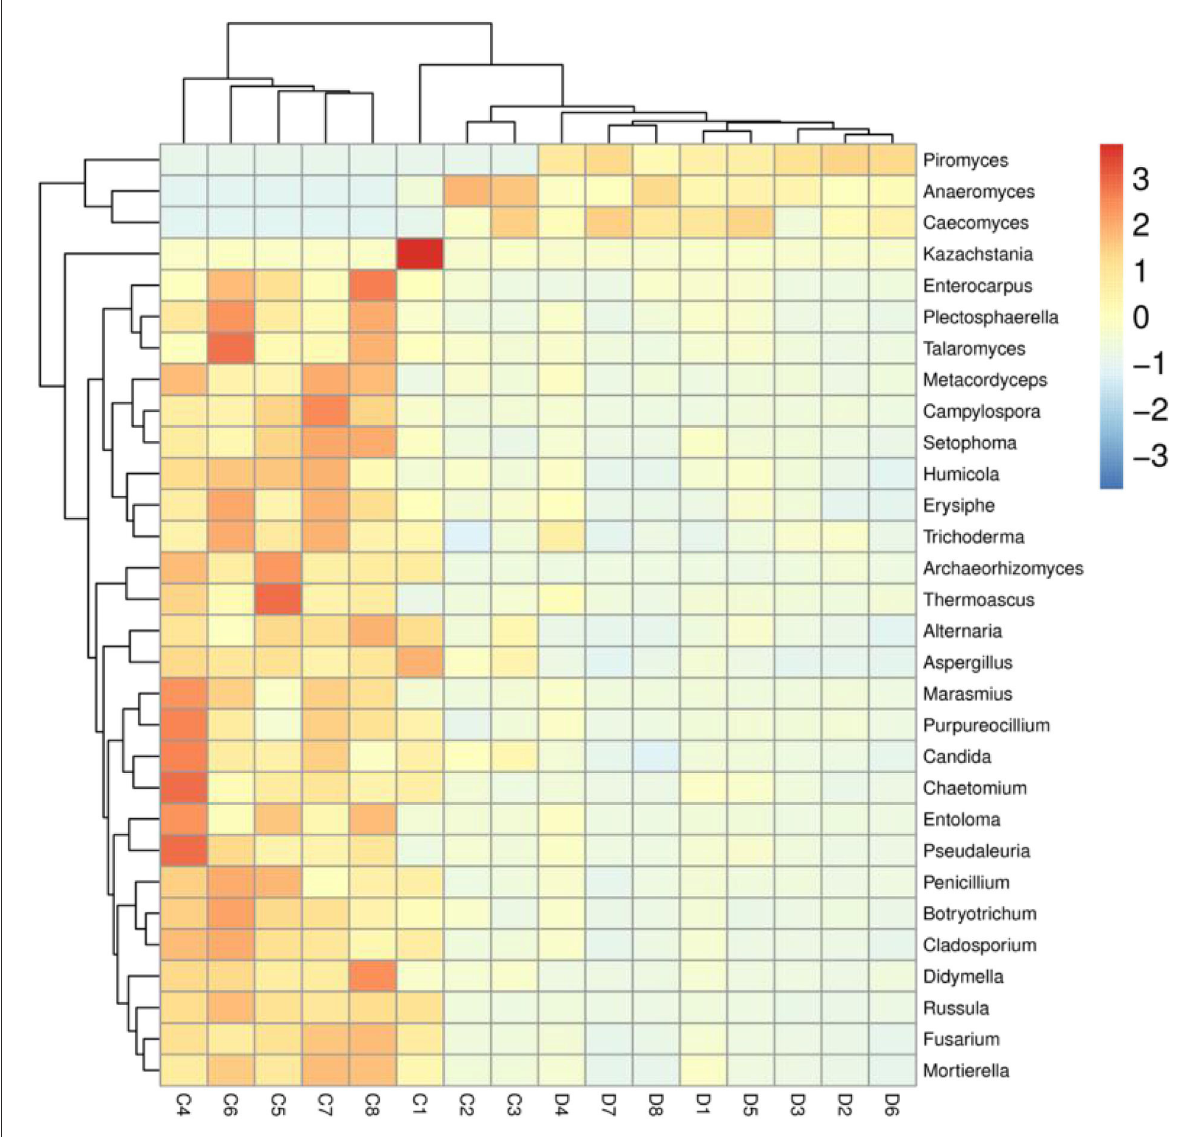
Kickxellomycota (0.023%, 0.00%) in healthy and diarrheic